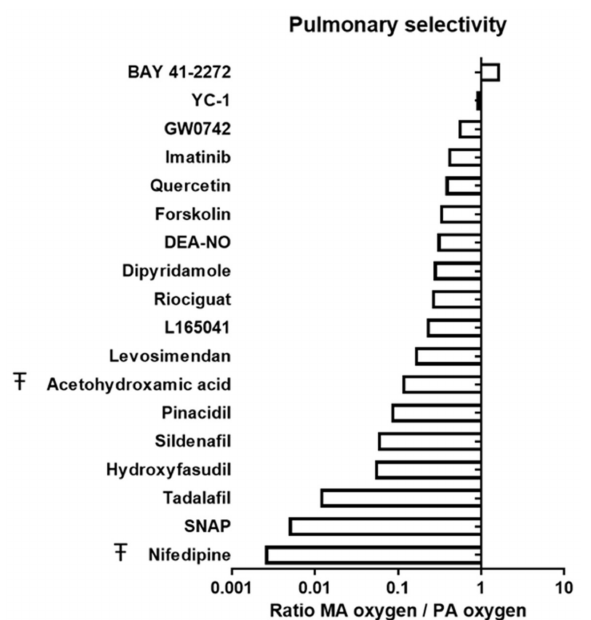
Figure 2. Selectivity of drugs for pulmonary vessels. Relative pulmonary selectivity of different vasodilator drugs in rat arteries. Data are expressed as relative potency (pIC 50 ) in MA vs PA under high oxygenation. Ŧ indicates that data are expressed as relative pIC 30 values in MA vs PA. Values > 1 indicate greater selectivity for PA oxygen; while values < 1 indicate greater selectivity for MA